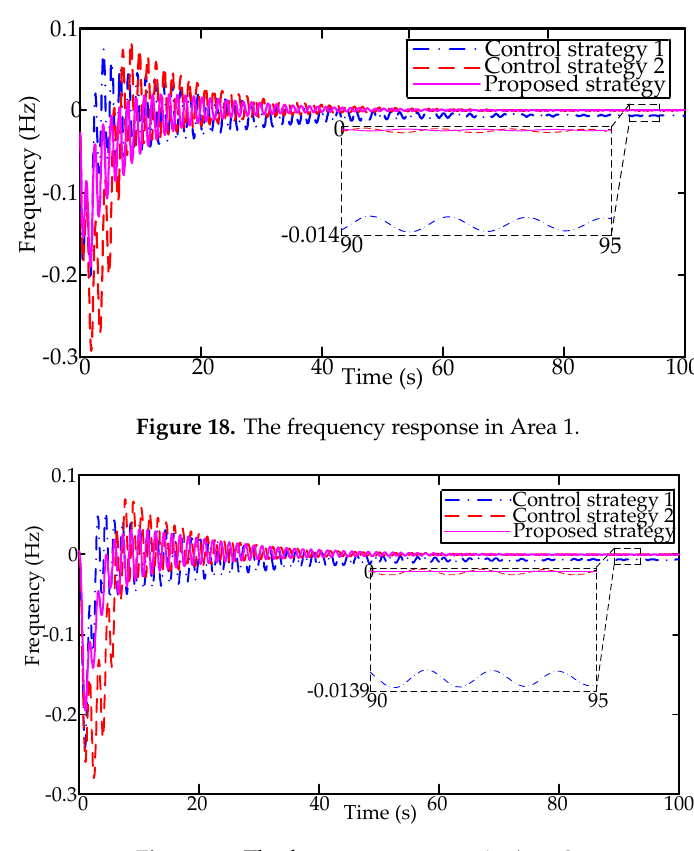
Figure 19. The frequency response in Area 2.